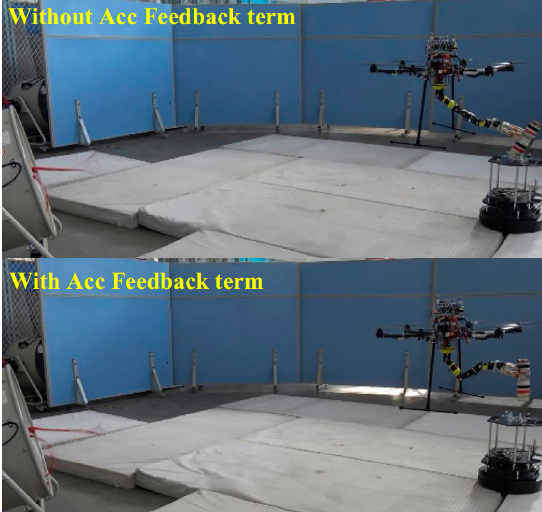
Figure 11. Aerial grasping of target object in the wind and the hex-rotor controlled without (up) and with (down) the acceleration feedback enhanced term.